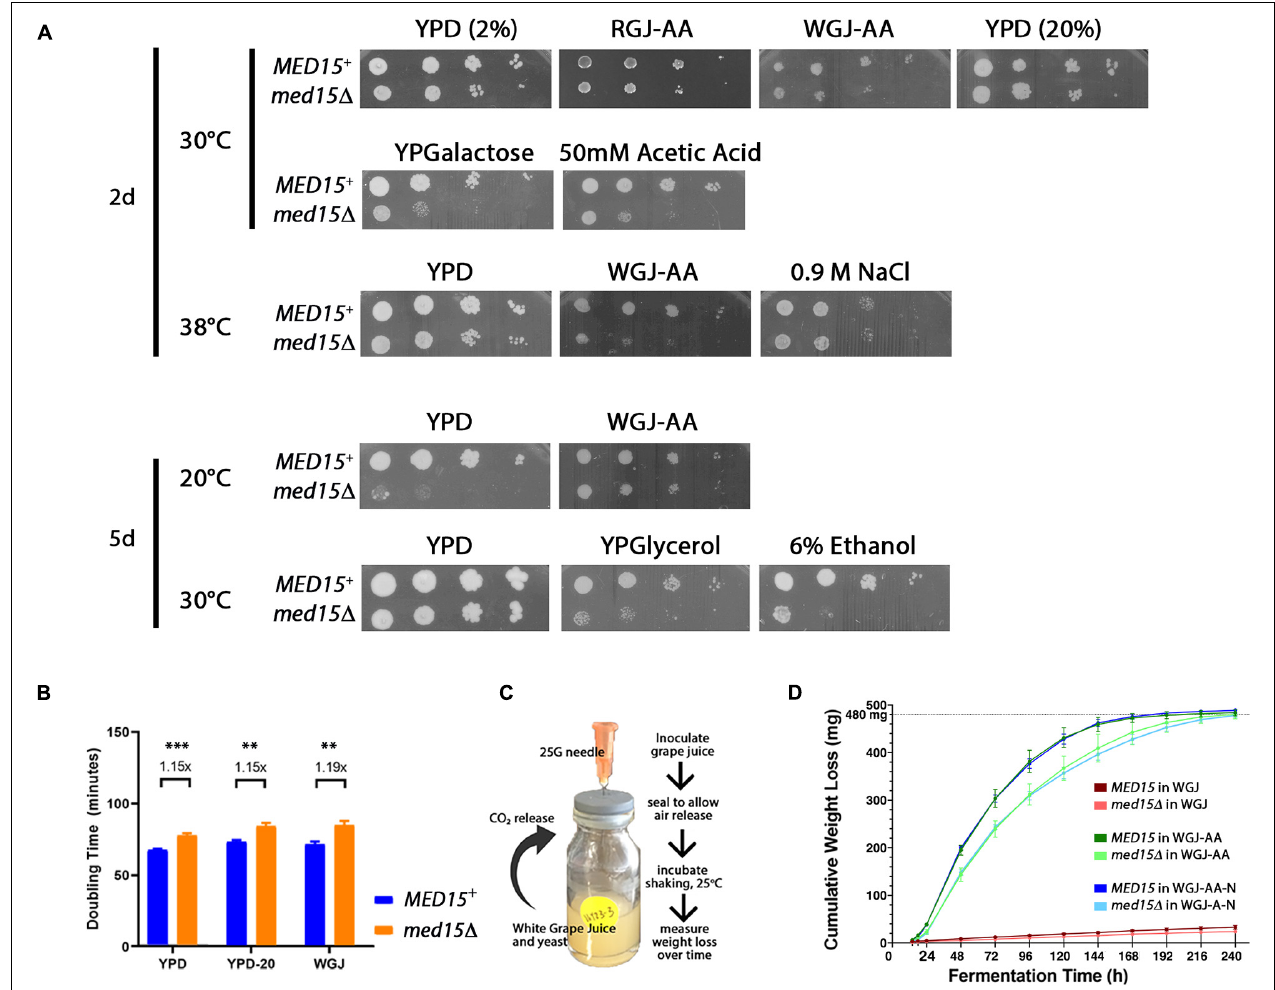
FIGURE 1 | Med15 growth and fermentation activities. (A) Phenotypic analysis using 10-fold serial dilutions of log-phase MED15 and med15 (cid:49) cultures spotted on rich YPD media where D is glucose/dextrose added to 2% (2%) or 20% (20%) with or without supplements (ethanol, acetic acid), or on YP media with galactose (YPGalactose) or glycerol (YPGlycerol) or on amino-acid supplemented white or red grape juice media (20–21 ◦ Bx with added leucine, histidine, lysine, and uracil; (white grape juice, WGJ-AA; red grape juice, RGJ-AA) at the indicated temperatures ( ◦ C). (B) Growth, depicted as doubling times of WT ( MED15 ) and med15 (cid:49) strains in rich media (YP) containing 2% glucose [YPD (2%)], 20% glucose [YPD (20%)], and supplemented white grape juice (WGJ) at 30 ◦ C. (C) Fermentation apparatus and experiment schematic. 1.25E7 cells were added to 5 mL of supplemented WGJ media in a small vial. A needle was inserted through the rubber seal to allow CO 2 escape. Vials were incubated at 25 ◦ C in a shaking incubator and measurements of weight loss were made daily. (D) Cumulative weight loss over 7 days for WT and med15 (cid:49) strains in WGJ (no supplements), WGJ-AA (amino acid supplemented), and WGJ-AA-N (amino acid plus nitrogen supplemented). For panels (B,D) , data points are the averages of 3–6 biological replicates (transformants) and error bars are the standard deviation of the mean. Weight loss comparisons between genotypes were significantly different ( p ≤ 0.01) at all time points in all media with the exception of 14 h in WGJ-AA ( Supplementary Figure 1 ). Significance was determined using two-tailed t -tests.